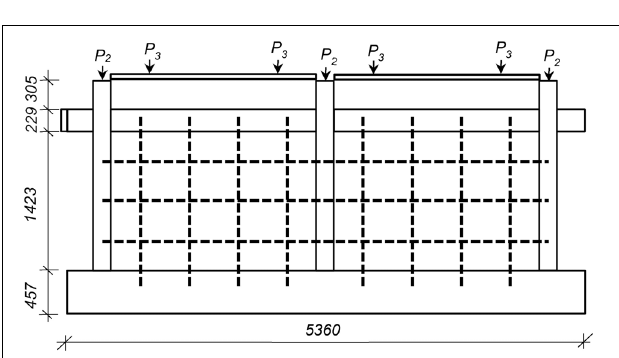
FIGURE 4 | Retrofit of the two-bay frame using three horizontal and four vertical NSM bars on each bay (2BR3H4V). Dimensions are in mm.